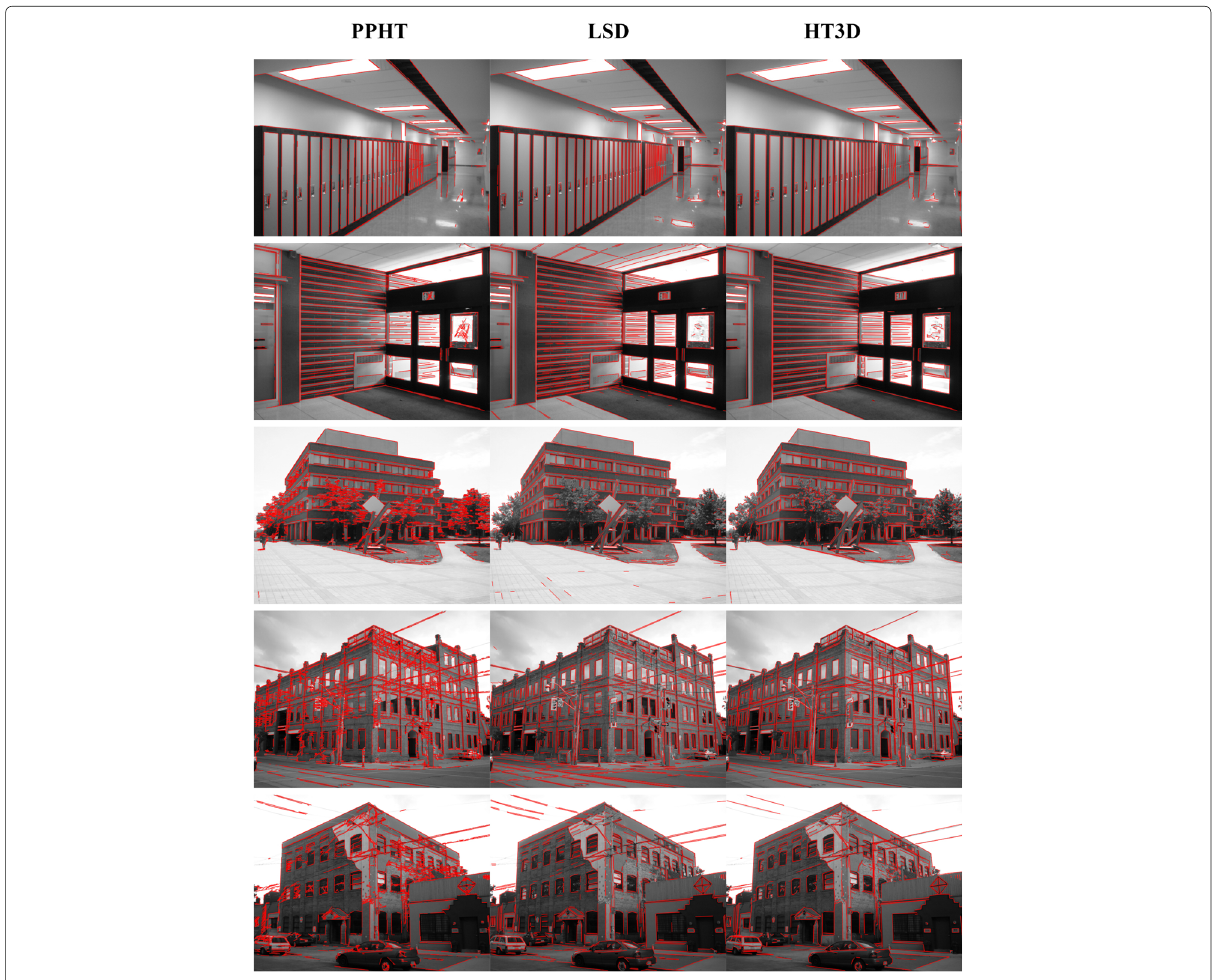
Fig. 20 Detected segments for the first set of